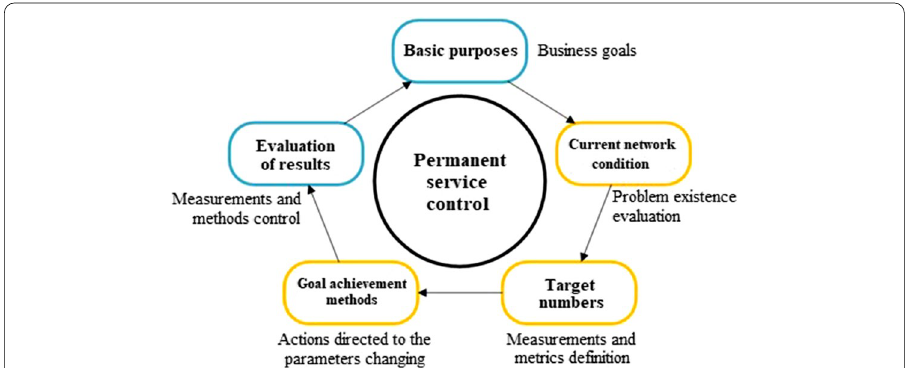
Fig. 2 Graphic representation of the service quality control